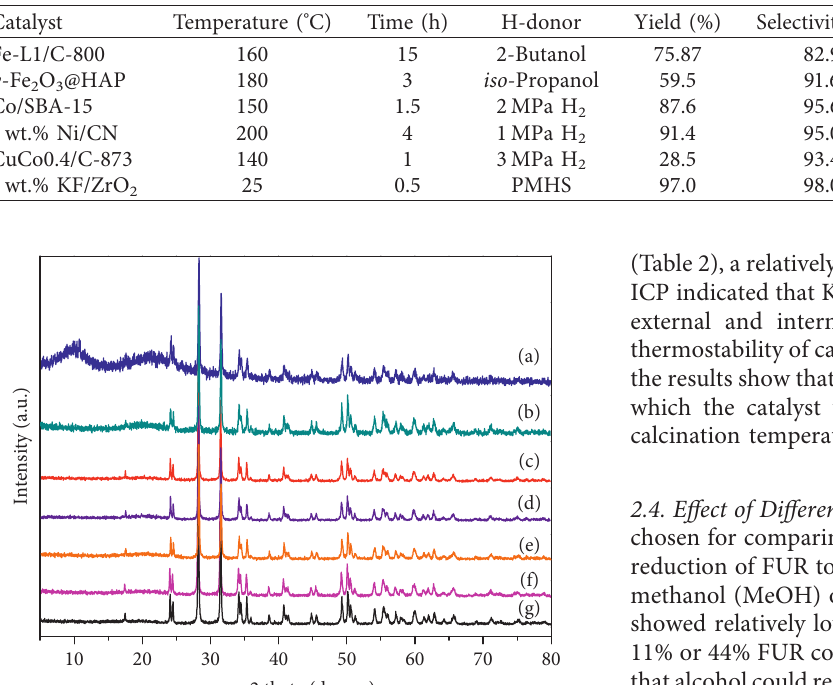
Figure 4: XRD patterns of (a) 5wt.% KF/ZrO 2 (after recycling 5 times), (b) 15wt.% KF/ZrO 2 , (c) 5 wt.% KF/ZrO 2 , (d) 3wt.% KF/ ZrO 2 , (e) 2wt.% KF/ZrO 2 , (f) 1wt.% KF/ZrO 2 , and (g) ZrO 2 .